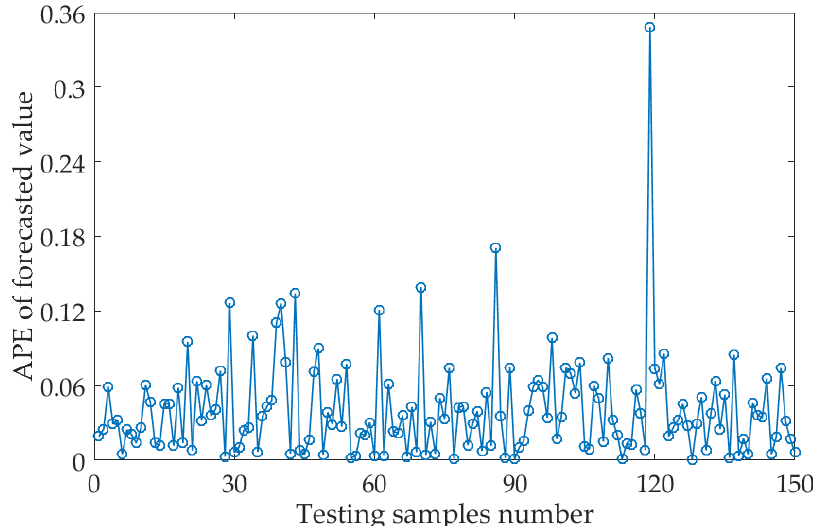
Figure 10. Comparison of actual values and forecasted calorific values based on the hybrid kernel function (where C = 16.98, σ = 1.35, ε = 0.02 and  = 0.79).